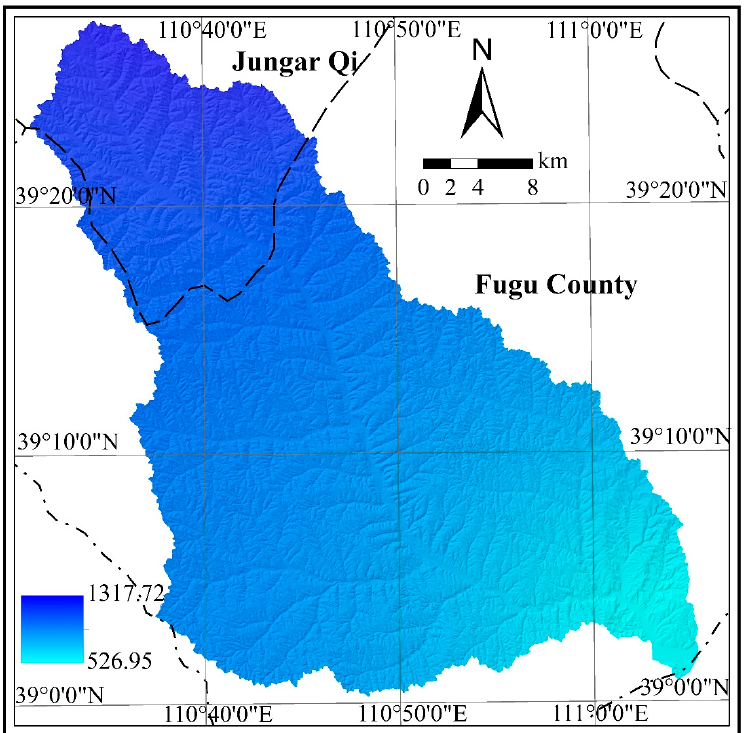
Figure 6. R Factor using row splitting based parallel algorithm.